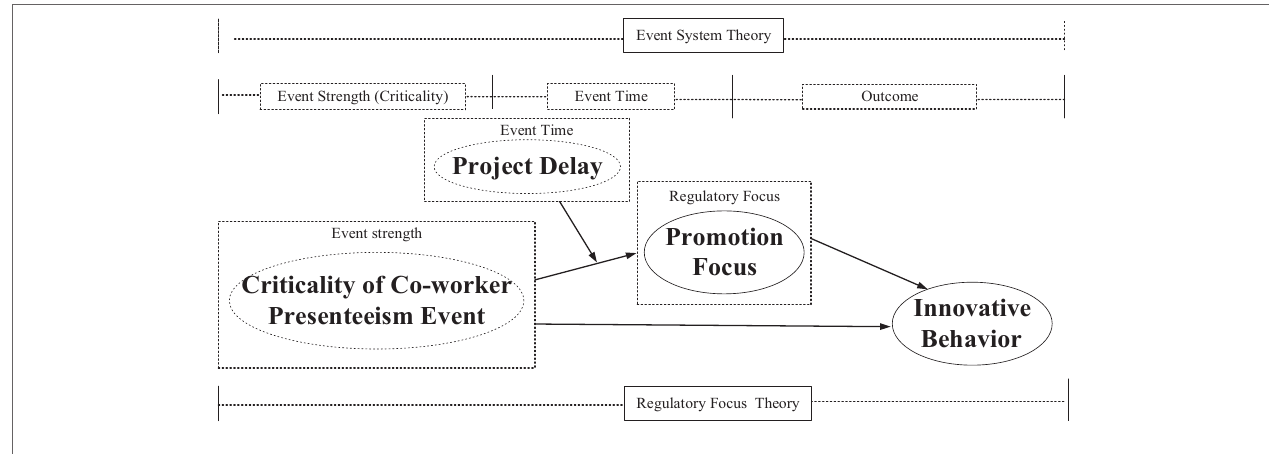
FIGURE 1 | Research